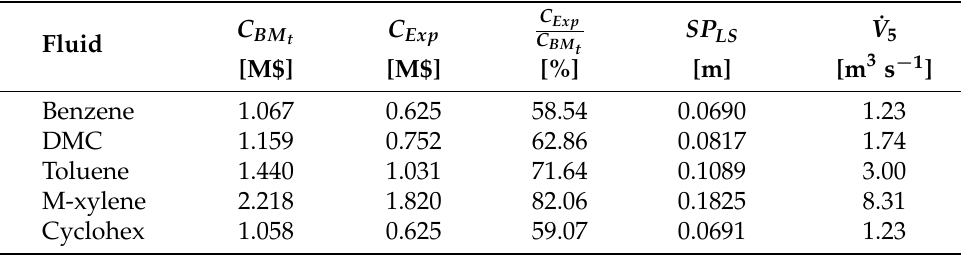
Table A12. Economic analysis results of the ORC fluids in the case of using oil as heat transfer medium in the thermal